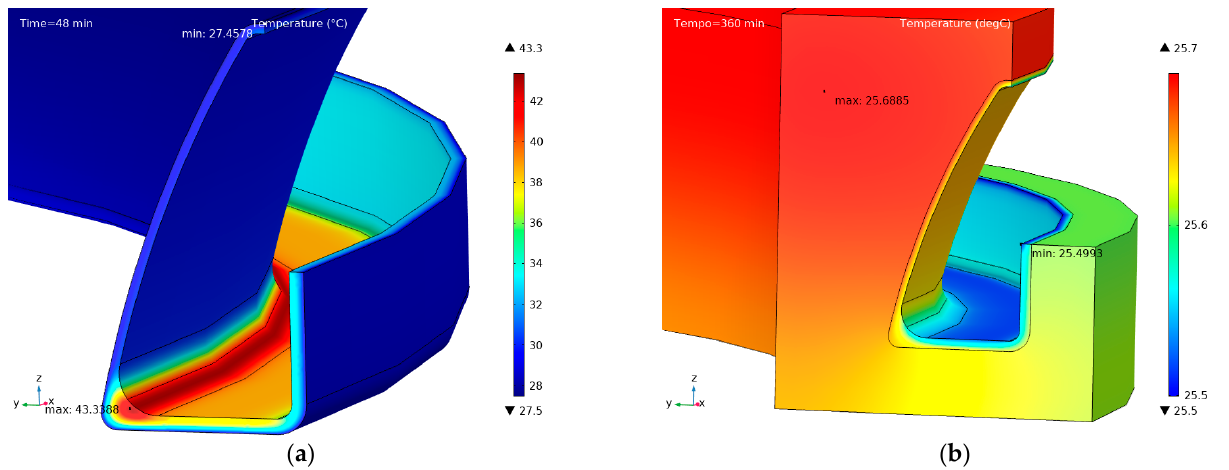
Figure 5. Temperature distribution plot: ( a ) only in the part at the ∆ Tmax value; ( b ) in the part and the mould, at the end of dwell phase before the cooling ramp for the curing cycle at 25°C.